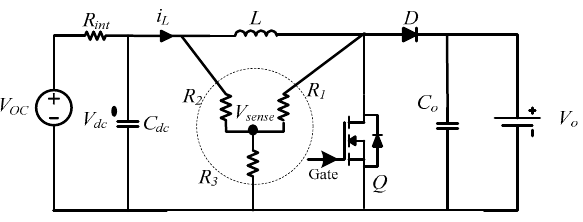
Figure 5. DC/DC boost converter with Thermoelectric Generator input.